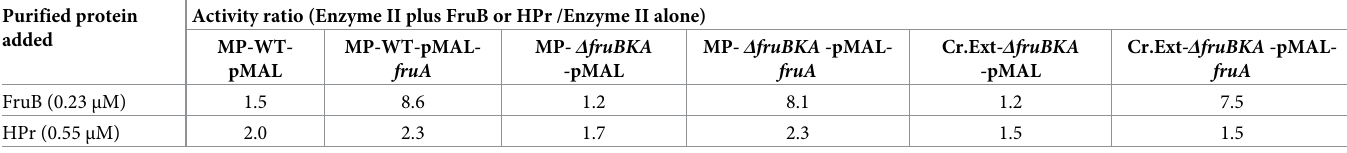
Table 5. Effect of purified FruB or HPr on the PEP-dependent phosphorylation of [ 14 C]mannitol using membrane pellets (MP) of E . coli strain BW25113-pMAL- fruA and BW25113- fruBKA : kn -pMAL- fruA or crude extracts (Cr.Ext.) of strain BW25113- fruBKA : kn -pMAL- fruA as compared to their corresponding control strains BW25113-pMAL and BW25113- fruBKA : kn -pMAL. Purified protein